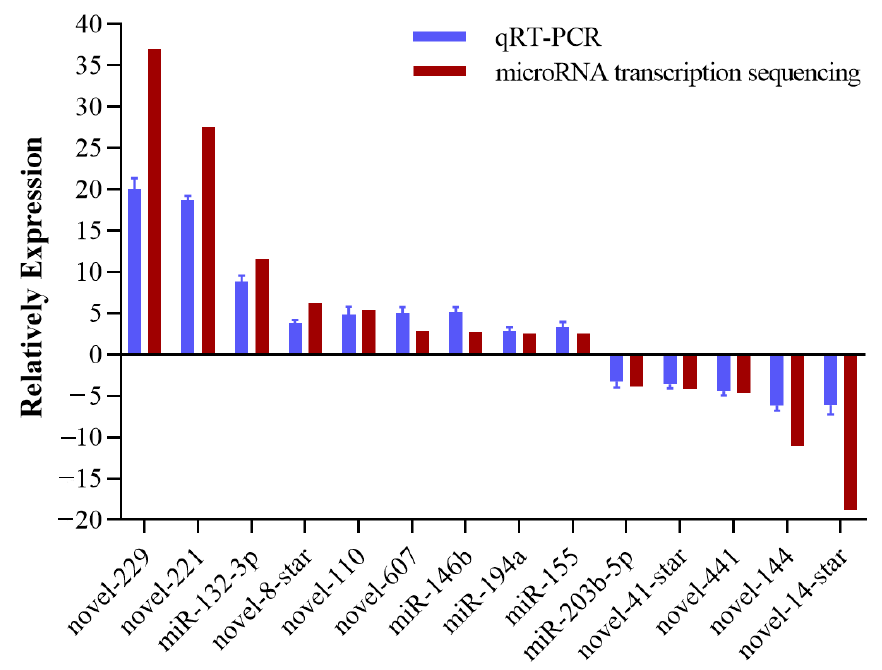
Figure 3. Validation of miRNA sequence data by qRT-PCR. Fourteen miRNAs were selected to validate the miRNA-seq data using qRT-PCR. Relative expression levels of change between the infected and control groups were calculated and normalized by the U6 housekeeping. Data in this assay were expressed as mean ± SEM ( n = 3).